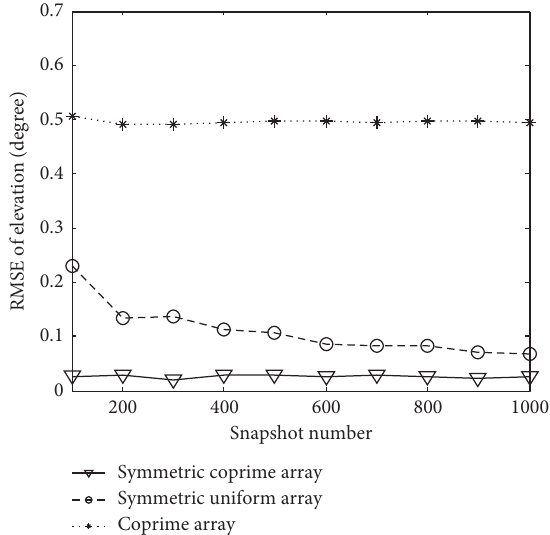
Figure 10: The RMSE of elevation versus snapshot number.